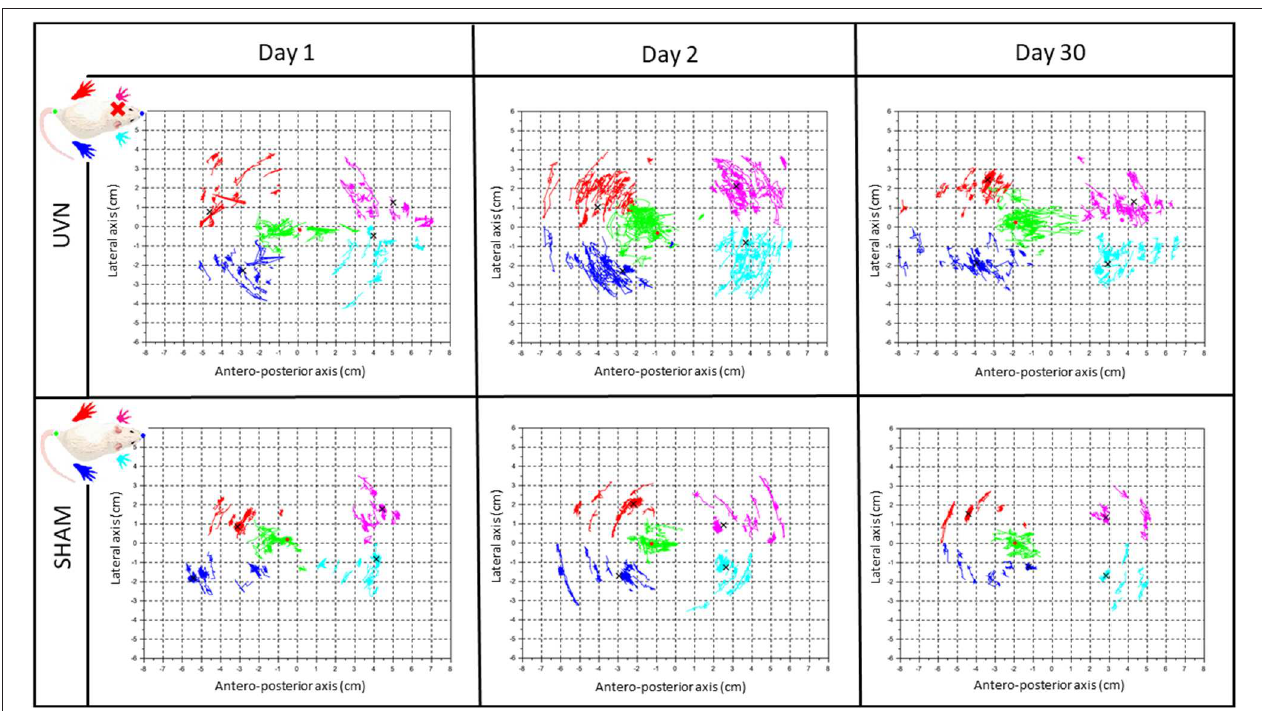
FIGURE 6 | The rodent stabilogram, a representative illustration of the kinetics of barycenter and paws positions. Plot of the successive positions of the legs and the barycentre at each moment when the animal is stationary with its 4 paws placed on the sensors during a 5-min acquisition. The first line of the table gathers the stabilograms of a representative UVN rat at different post-UVN days (Day 1, Day 2, and Day 30), the second line gathers the stabilograms of a representative SHAM rat at these same post-UVN days times. For each stabilogram, the antero-posterior axis is on the abscissa and the lateral axis on the ordinate. The dark blue, red, light blue and pink dot clouds are the traces of the average positions, respectively, of the right rear paws, left rear paws, right front, and left front paws during a session at each moment when the animal is static on its four legs. The green point cloud is the trace of the successive positions of the barycentre calculated at each of these moments. The different black crosses represent the average position of the legs during an entire session. The red dot represents the average position of the barycentre during a session. The pattern of stabilograms appears stable in SHAM rats, compared to the UVN group where the pattern appears more instable at the three representative post-UVN